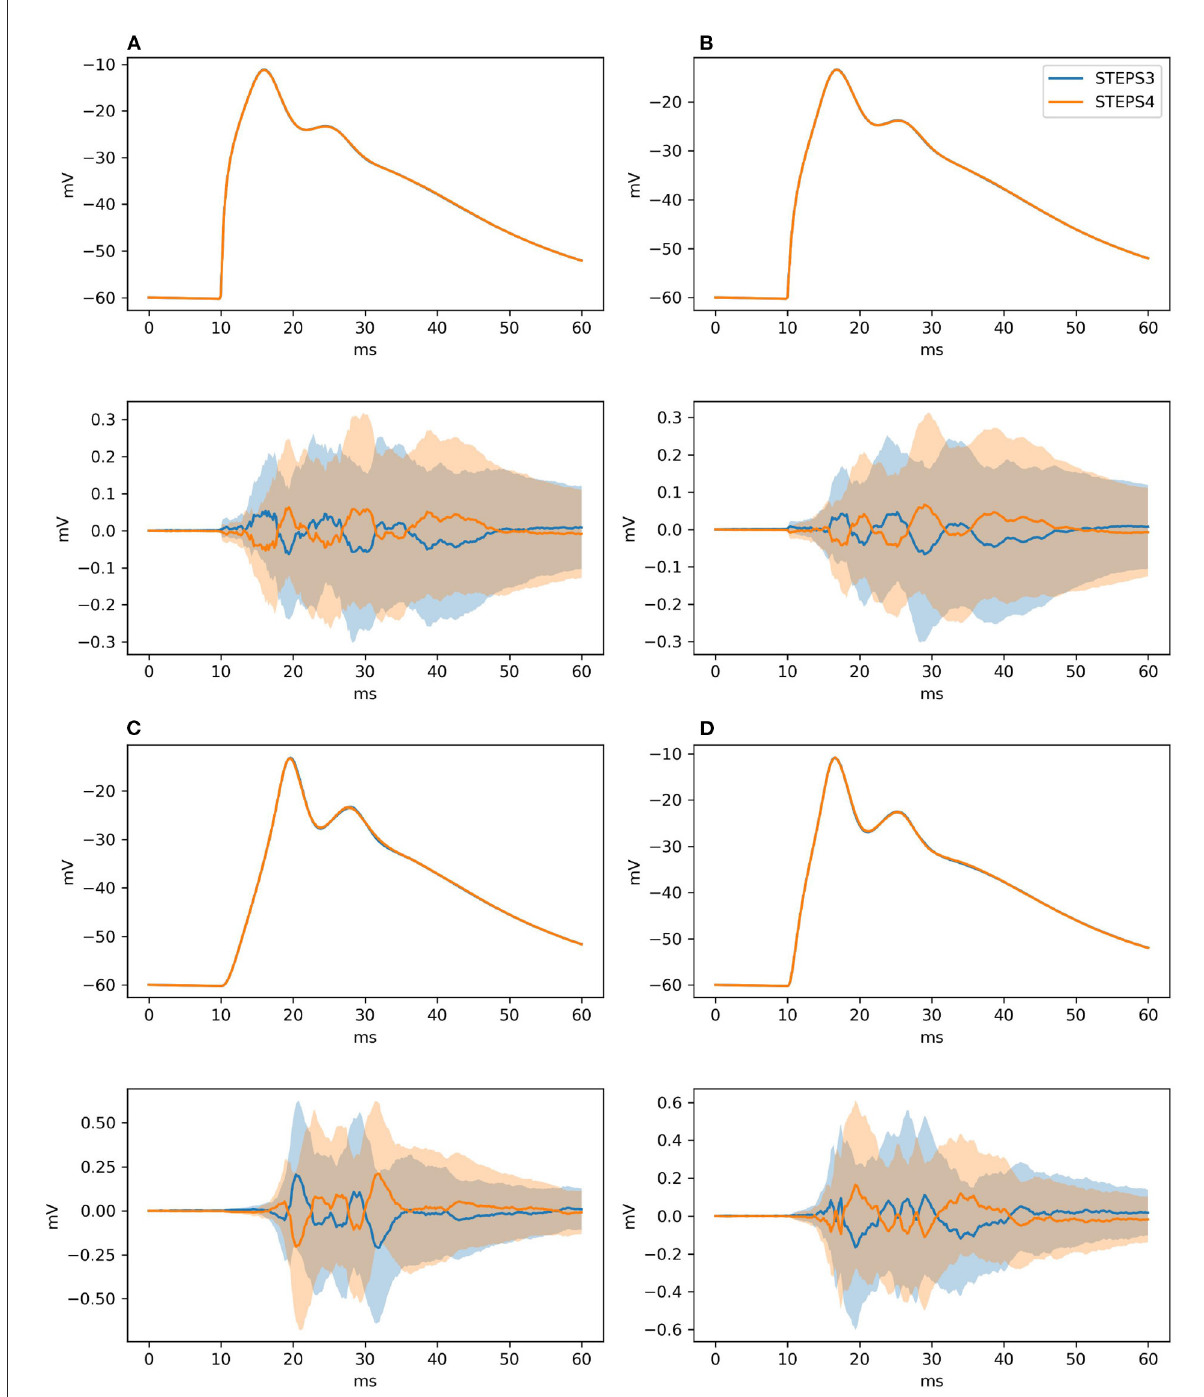
FIGURE7 The panels illustrate average and confidence intervals (at 99% probability) of STEPS 3 and STEPS 4 simulation sets for the voltages measured at: (A) root and (B) middle point on the spiny membrane, and on (C) left and (D) right tip on the smooth membrane. Since confidence intervals are extremely narrow, the lower subplot in each panel presents the results relative to the average of all traces so that the confidence intervals can be seen clearly. Each sample consists of 100 runs. Since averages lie everywhere in each other confidence intervals we cannot refute the null